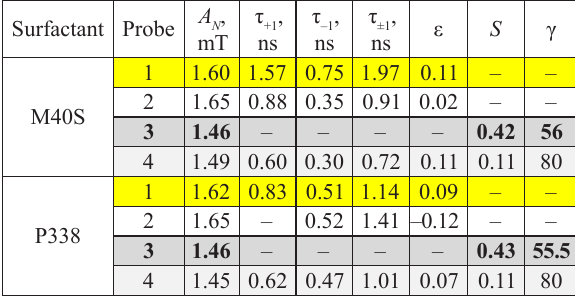
M40S and P338 A , N mT